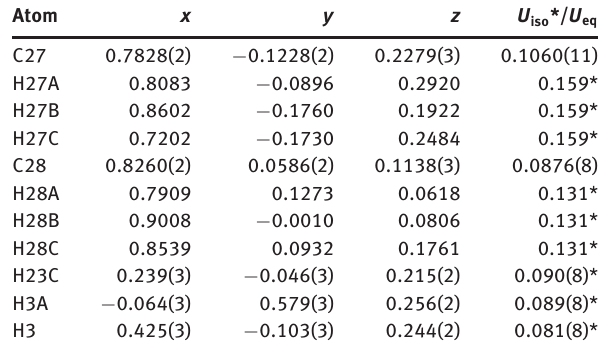
Table 2: Fractional atomic coordinates and isotropic or equivalent isotropic displacement parameters (Å 2